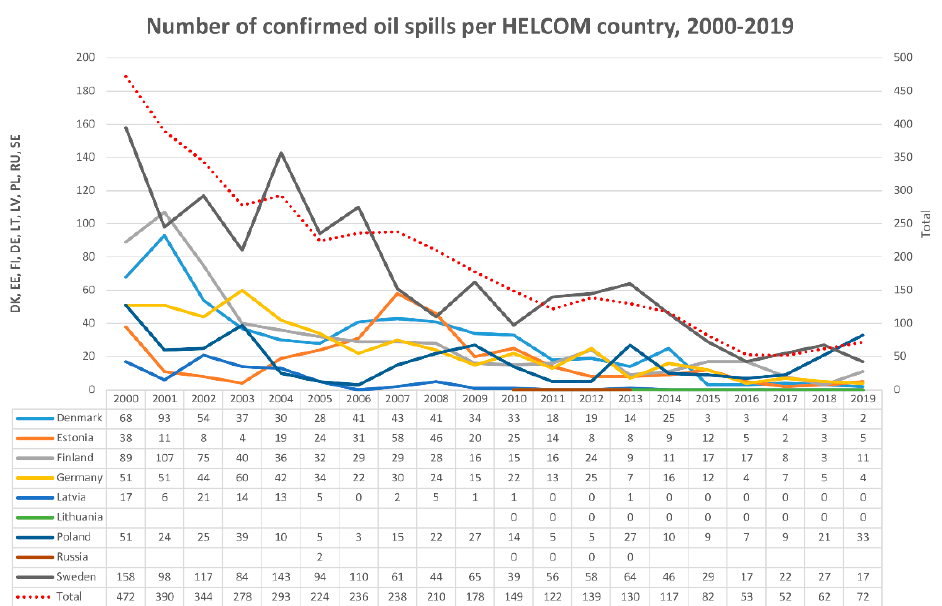
Figure 8. Number of confirmed oil spills per HELCOM country in 2000–2019. Note that the total number of spills is indicated on the vertical axis on the right, which uses a different scale (Figure 3 from [6]).